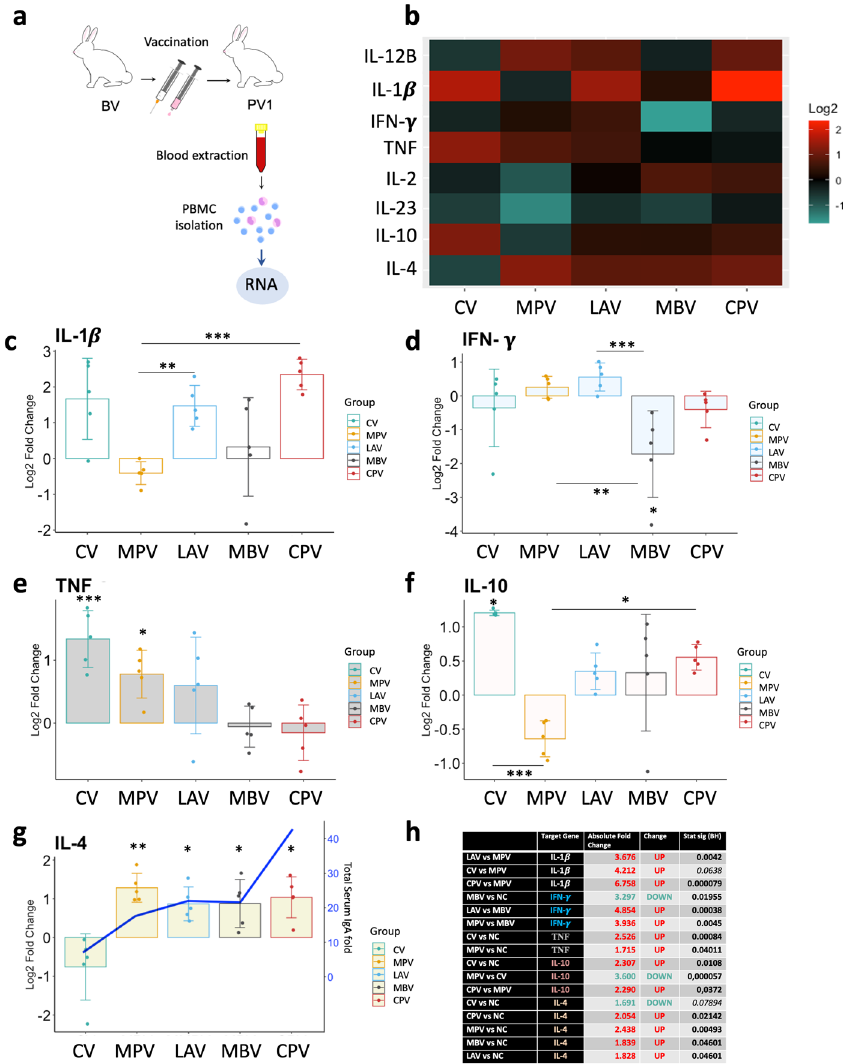
Fig. 6 Cytokine relative quanti fi cation by RT-qPCR of PBMCs isolated from animals at PV1 (1 month after fi rst dose vaccination) relative to the NC. a Schematic representation of sample origin. b Heatmap representation of cytokine expression of vaccinated groups; in red upregulated and in green downregulated gene expression. Bar charts showing log2 fold change between vaccinated groups and NV. c IL-1 β , d IFN- γ , e TNF, f IL-10, g IL-4 and blue line represents serum total IgA level fold PV1-BV. h Table summarizing the signi fi cant differences between groups in cytokine expression and the Absolute Fold Change Factor. All values were means with error bars representing standard deviation from groups of n = 5, except for NV which was n = 5. ANOVA with pooled SD with Benjamini & Hochberg correction was applied and signi fi cation levels are * p < 0.05, ** p < 0.01,